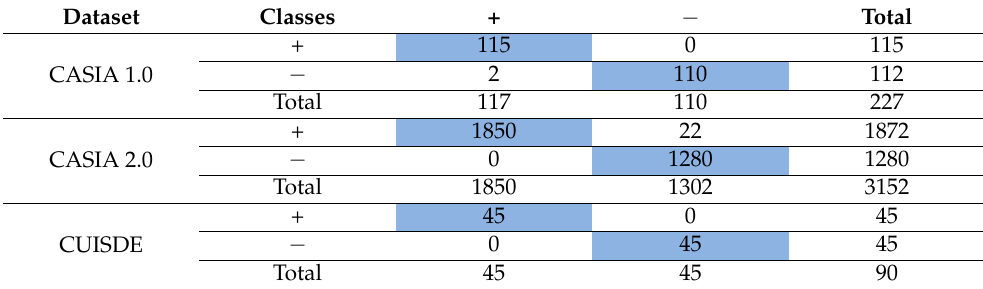
Table 3. Confusion matrices of the proposed model over CASIA 1.0, CASIA 2.0, and CUISDE dataset.